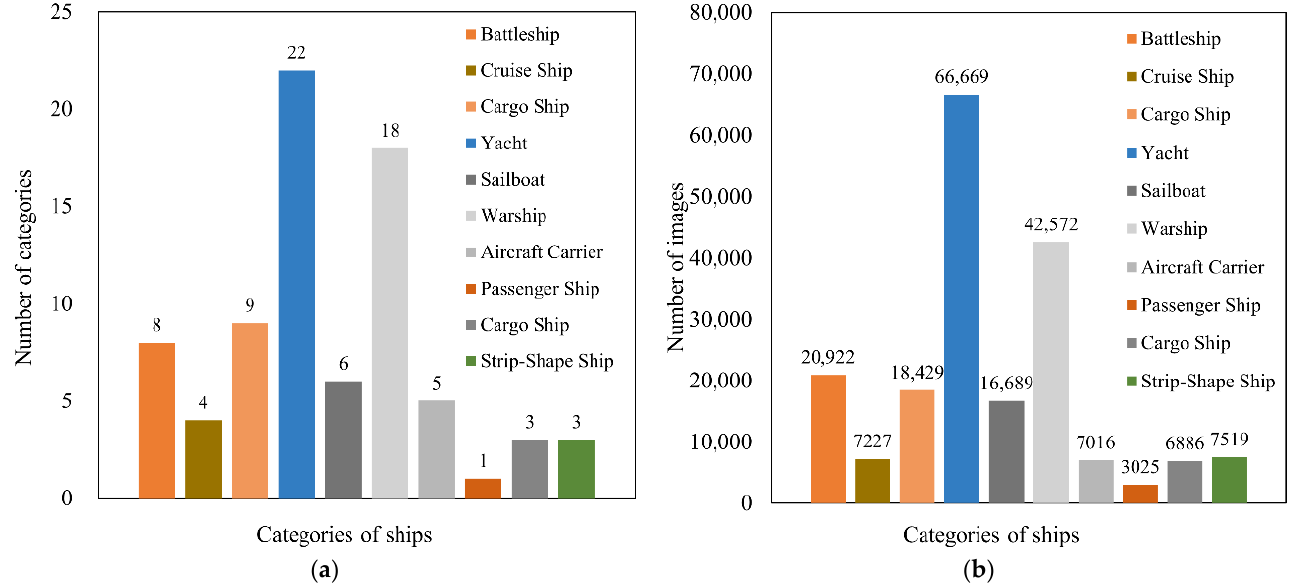
Figure 5. Category information of ship models: ( a ) the number of ship models contained in each category, and ( b ) the number of ship instances per category.